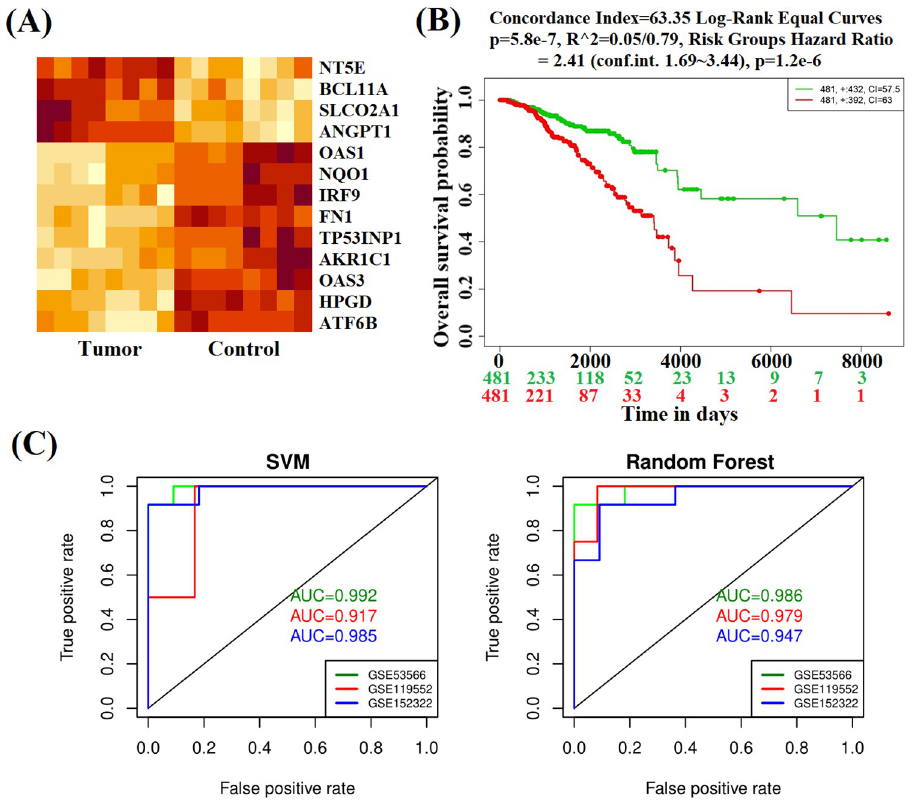
Fig 5. The prognostic powers of KGs were displayed by (A) Heatmap of hierarchical clustering (B) Multivariate survival curves with KGs and (C) ROC curves of prediction models with KGs.